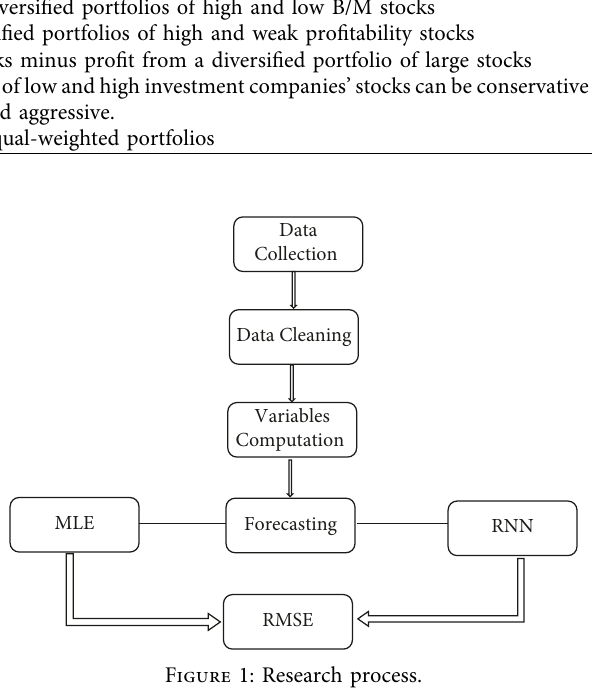
Figure 1: Research